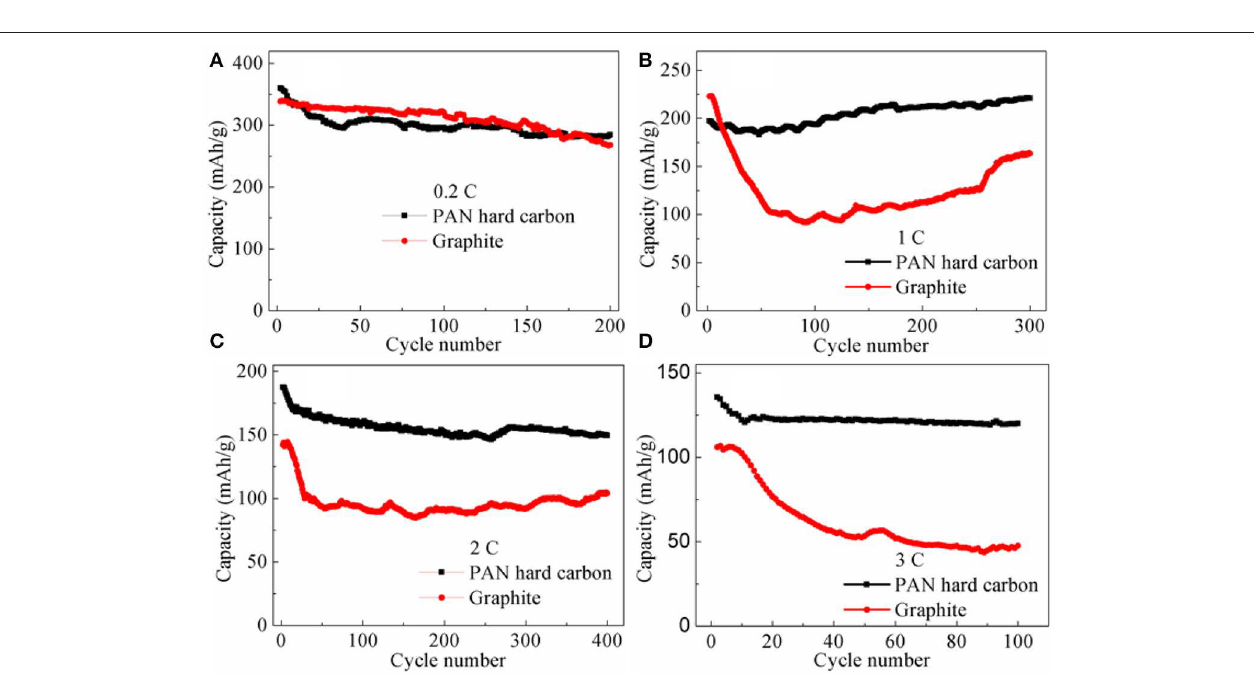
FIGURE 5 | Rate cycle performance of PAN hard carbon electrode and graphite electrode at different current rates (A) 0.2C; (B) 1C; (C) 2C; (D) 3C.